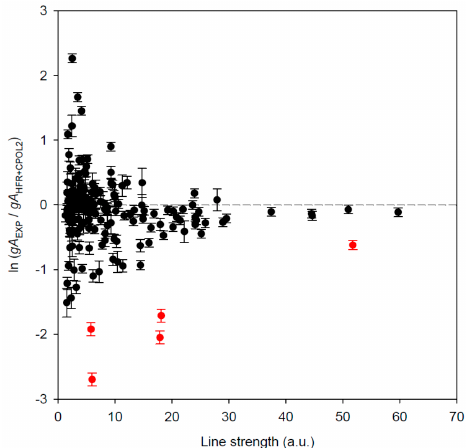
Figure 6. Dependence of residuals (experiment-theory) on the line strength S (in atomic units) calculated in this work. The experimental gA ‐ values ( gA EXP ), together with their error bars, originate from Den Hartog et al. [22] The red outlying points have been excluded from uncertainty evaluation (see text).